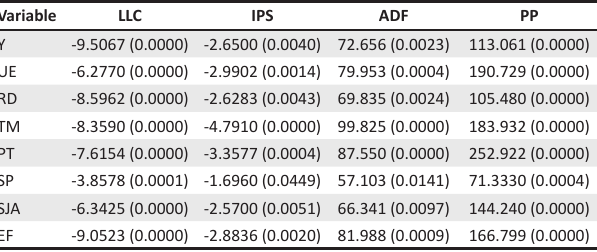
Note: probabilities for Fisher tests are calculated using asymptotic Chi-square distribution. All other tests assume asymptotic normality. Values in parentheses are the probability values for the tests. Y, GDP per capita growth; UE, university enrolment for science and engineering students; RD, government research and development expenditure; TM, value of high-tech export; PT, total number of patents; SP, scientific personnel; SJA, scientific and technical journal articles; EF, economic